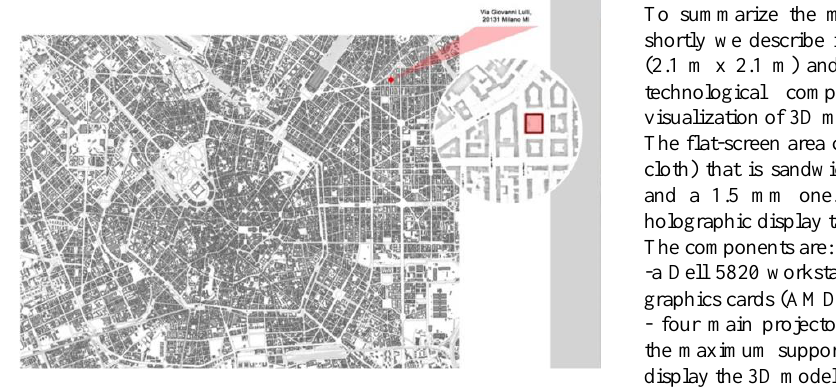
Figure 1. Lulli district and block in the urban area of Milan.